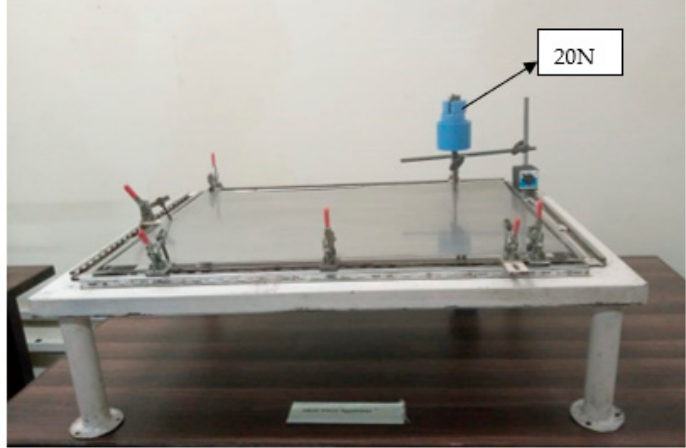
Figure 13. Experimental Setup of Case Study 1—Flat Plate. Figure 12. Experimental Setup of Case Study 1—Flat